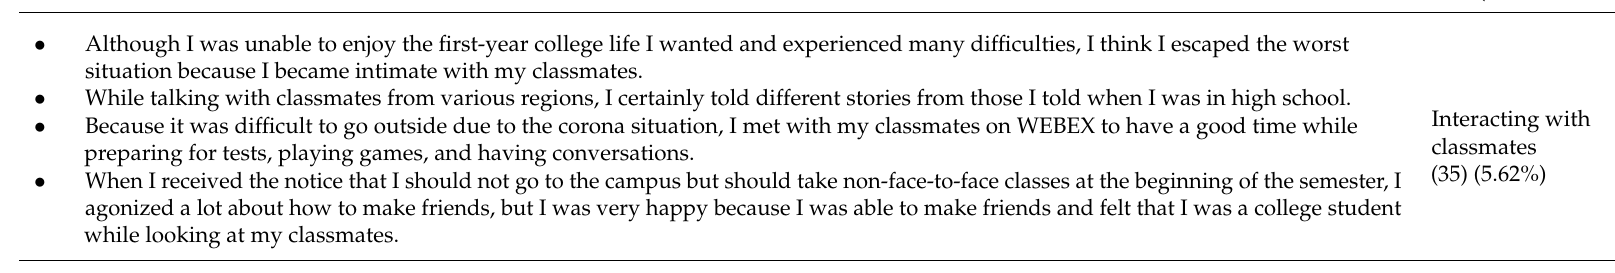
Table 4. Drawing on resources to create relationships or produce results (n = 107) (17.17%).